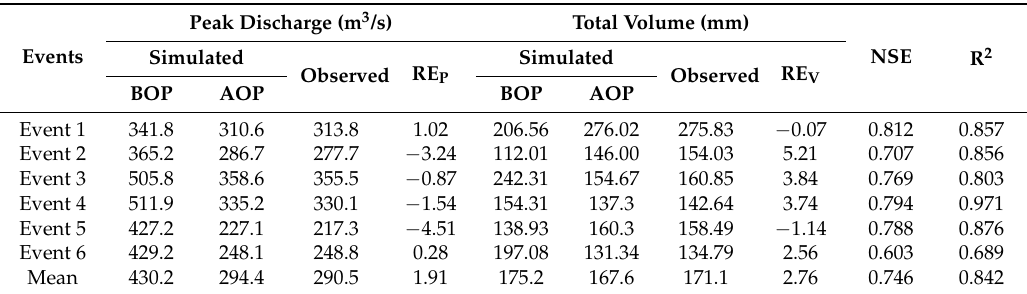
Table 3. Simulated (before and after optimization) and observed peak discharges and total volume and after optimization error functions.